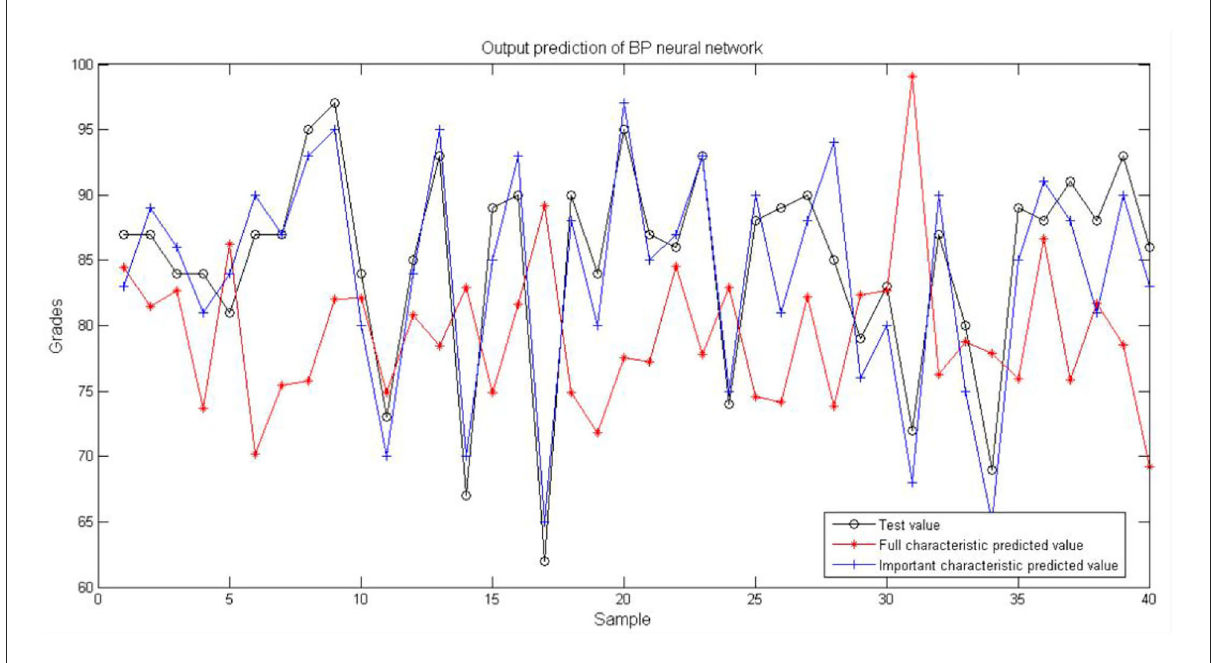
FIGURE4 Prediction result of BP neural network.